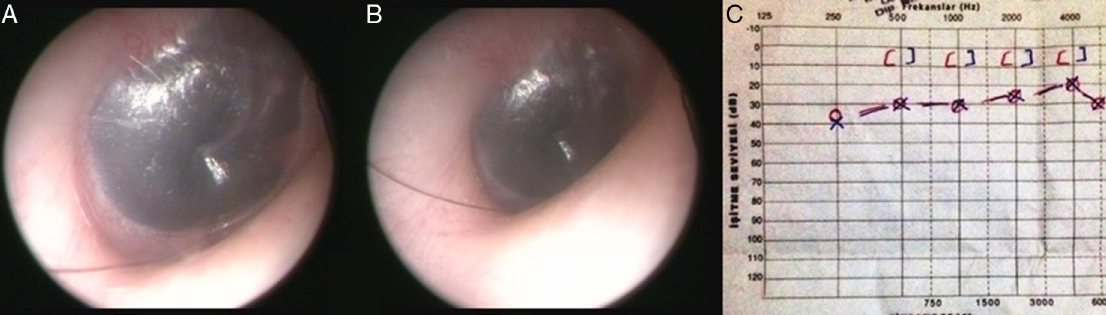
Figure 1 (a) Microscopic view of the right tympanic membrane. (b) Microscopic view of the left tympanic membrane. (c) Audiogram of the patient demonstrating bilateral conductive hearing